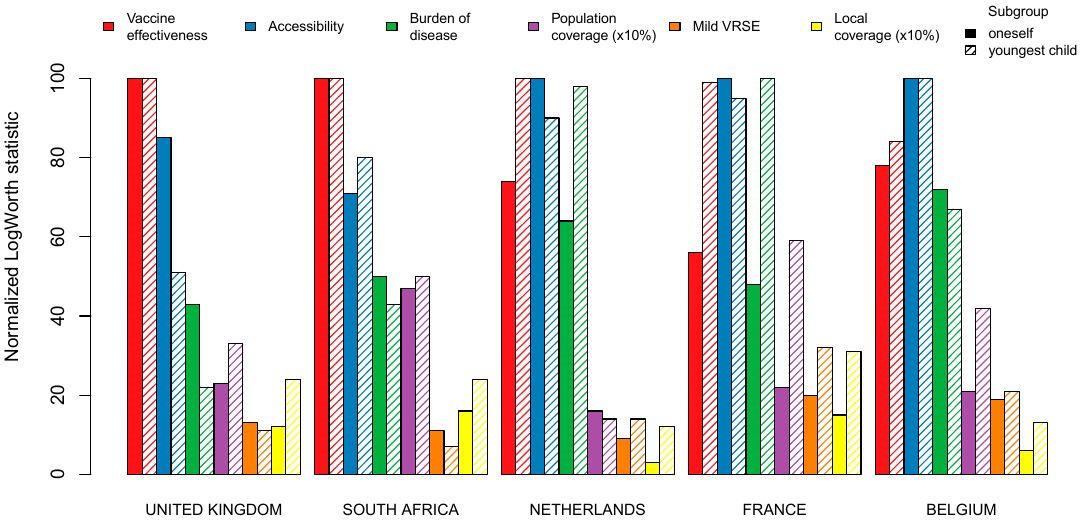
Figure 3. Importance of all statistically significant ( p -value < 0.05) main effects relative to the most important attribute in each study sample. Estimates for the Netherlands and South Africa are derived from Hoogink et al. [31] and Verelst et al. [24] . Table 3. Panel mixed logit model estimates (means and standard deviations) and significances of the attribute effects obtained from likelihood ratio (LR) tests. Belgium.